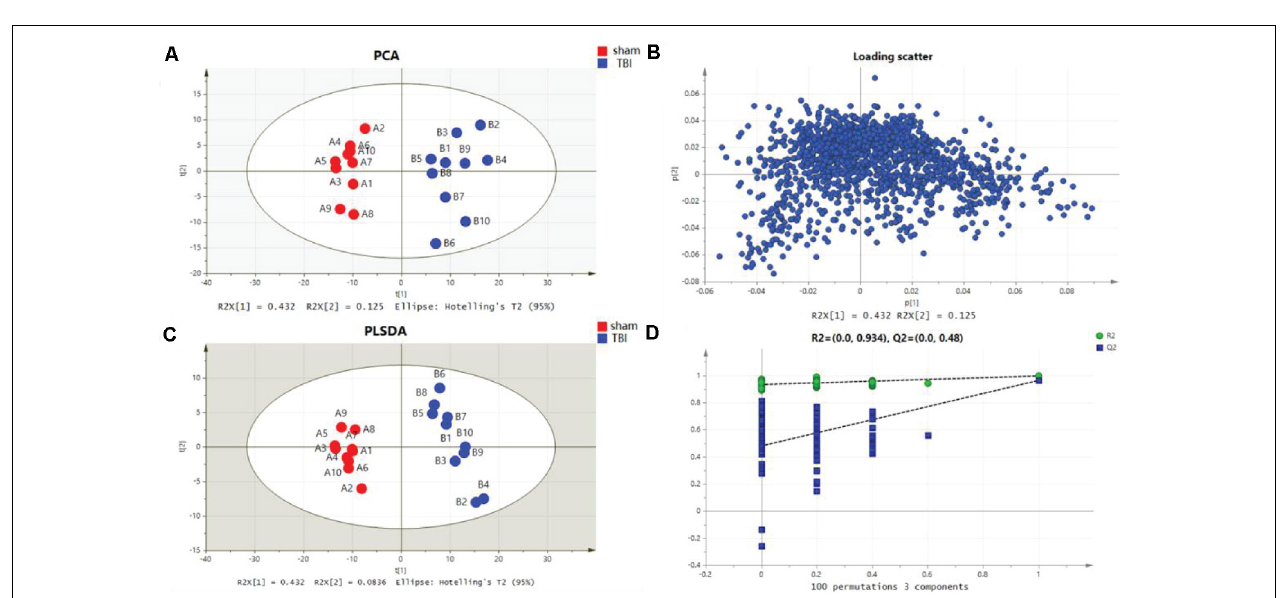
FIGURE 3 | Metabolomic fingerprint analysis for the cortex in principal component analysis (PCA) and partial least-square discrimination analysis (PLS-DA). (A) PCA plots in cortical traumatic brain injury (TBI) vs. sham. (B) Loading plot corresponding to the PCA score scatter plot for cortical TBI. (C) PLS-DA results for cortical TBI [R2Y (cum) = 0.965 and Q2Y (cum) = 0.895]. (D) Validation plot obtained from 100 permutation tests for the cortex.